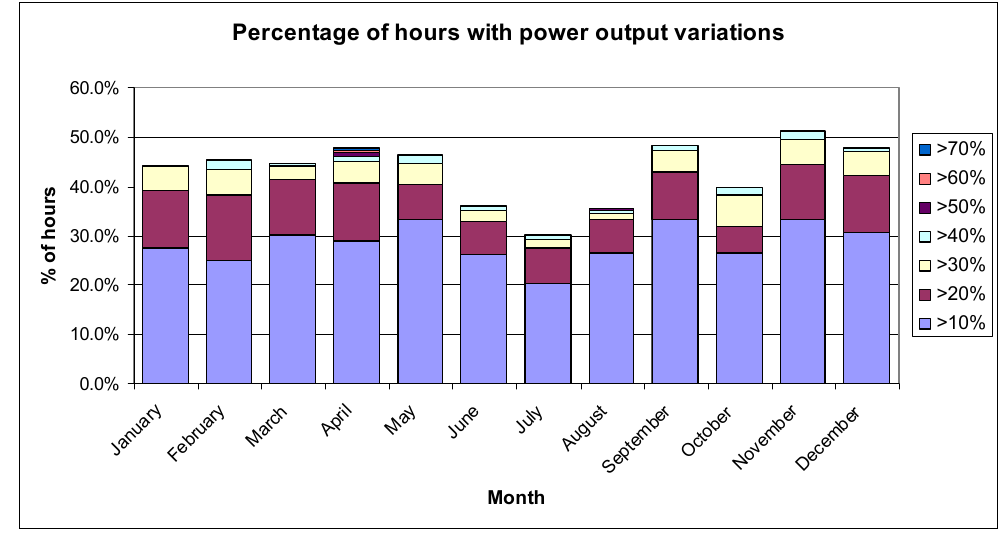
Figure 3. Percentage of hours with power output variations with respect to power rating of the PV